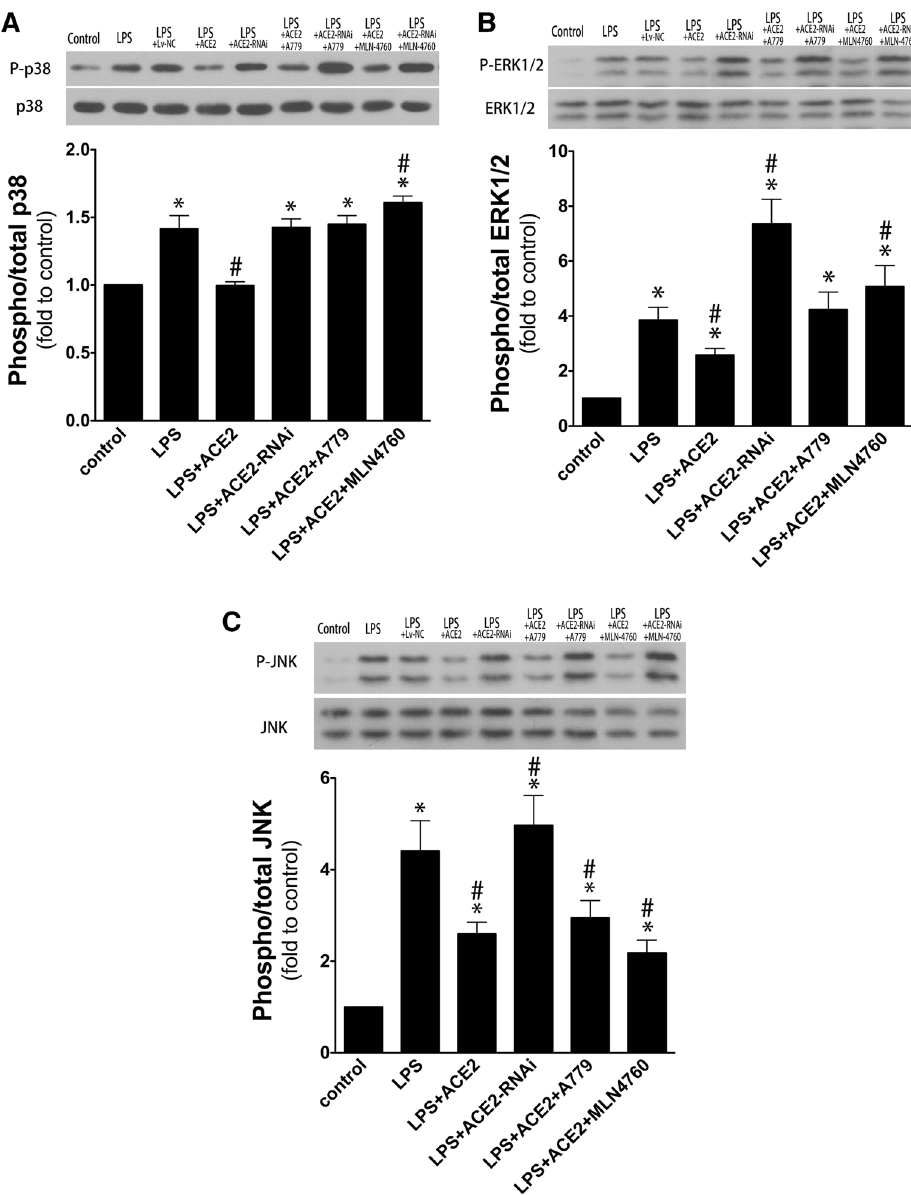
Figure 6. Effects of ACE2 and different treatments on the phosphorylation of MAPKs in lung tissue. LPS exposure caused a marked increase of the phosphorylation levels of p38 MAPK ( A ), ERK1/2 ( B ) and JNK ( C ), which was significantly suppressed by ACE2 overexpression in rat lung. Pretreatment with A779 or MLN-4760 completely abolished the inhibitory effects of ACE2 overexpression on LPS-induced p38 MAPK and ERK1/2 phosphorylation, but did not affect the level of JNK phosphorylation. ACE2 RNAi in rat lung significantly enhanced the LPS-induced ERK1/2 and JNK phosphorylation but did not change p38 MAPK phosphorylation. Data are represented as mean ± SD. * p < 0.05, versus control group; # p < 0.05, versus LPS group; $ p < 0.05, versus ACE2 group (n = 6, per